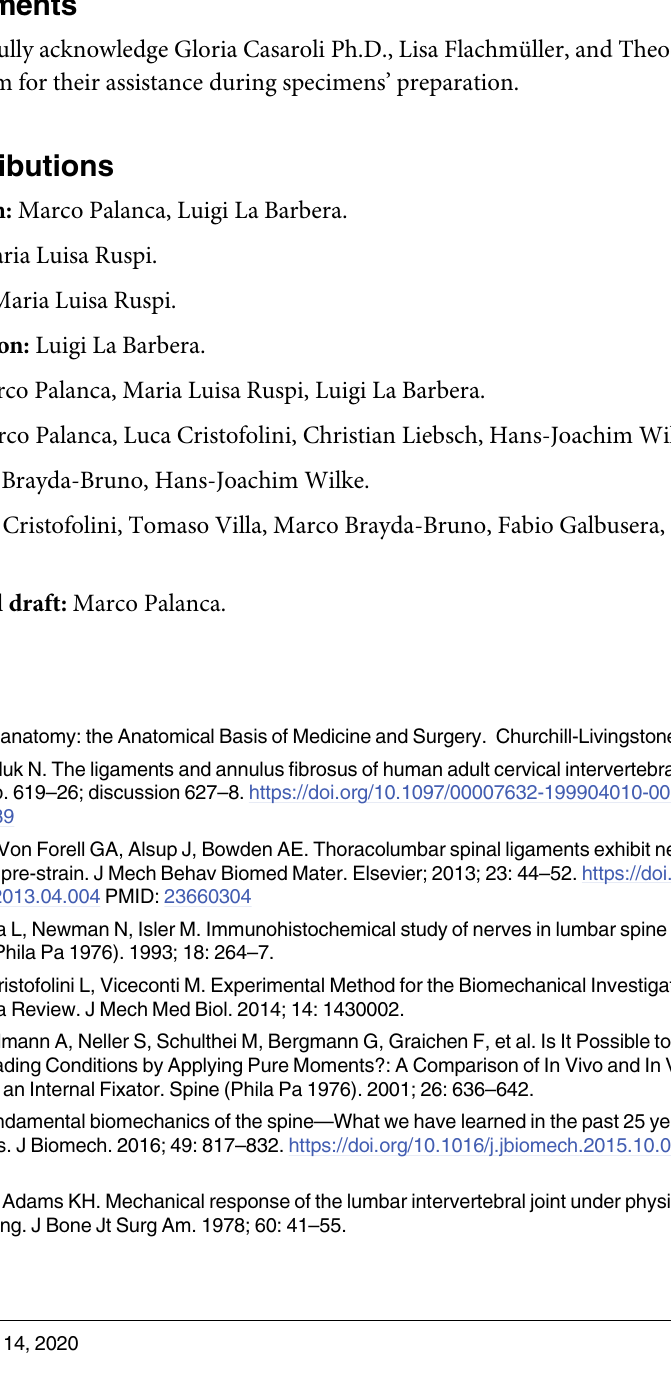
S1 Dataset. Raw data at max load. The maximum (eps1) and minimum (eps2) principal strains measured through the Digital Image Correlation on each specimen were reported with their spatial coordinates. (XLSX) S2 Dataset. Markers for local analysis. The spatial coordinates of the regions of interest in front of the vertebra and the in front of the intervertebral disc were reported for each specimen for each loading condition in both the directions.